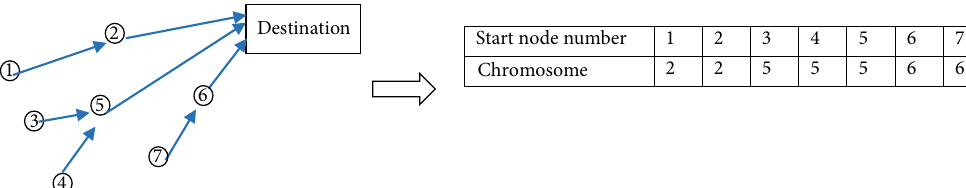
Figure 15: Coding of the genetic